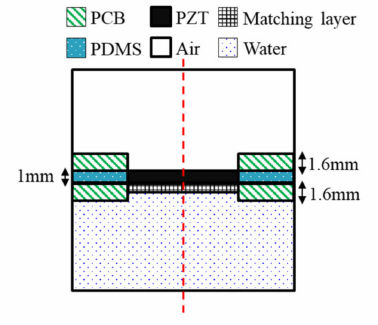
Figure 3. Geometry of the finite element